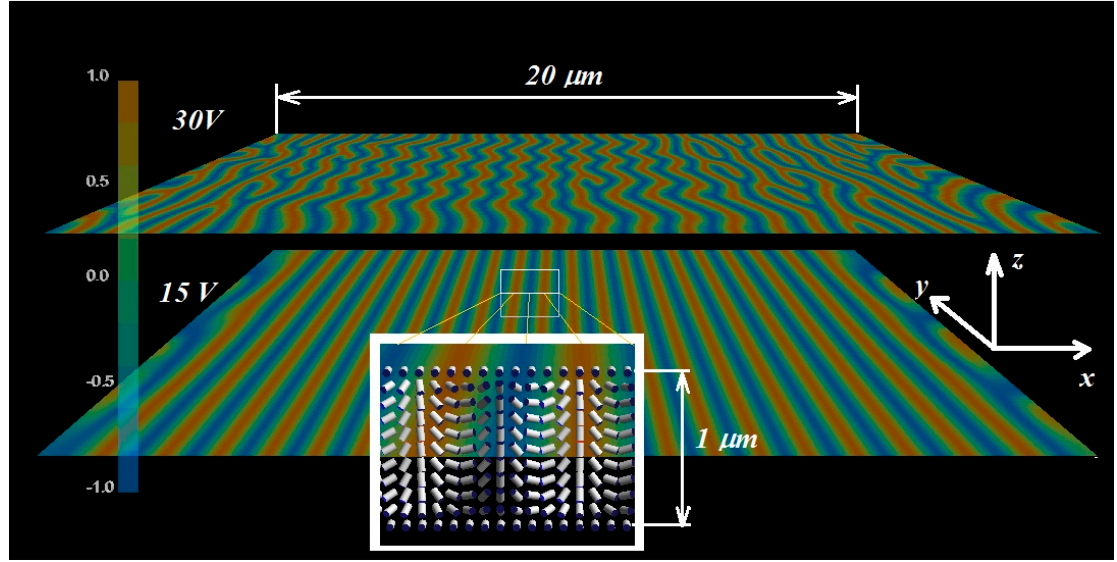
Figure 2. In-plane director distribution in the middle (z = 0.5 μ m) of the LC layer at voltages of 15 V (bottom plane) and 30 V (top plane) applied across the LC layer of a thickness of one micrometer. The color scale is for the z-component of the LC director. The inset shows the director distribution in the xz-plane for a fraction of the calculation domain in the middle at 15 V.